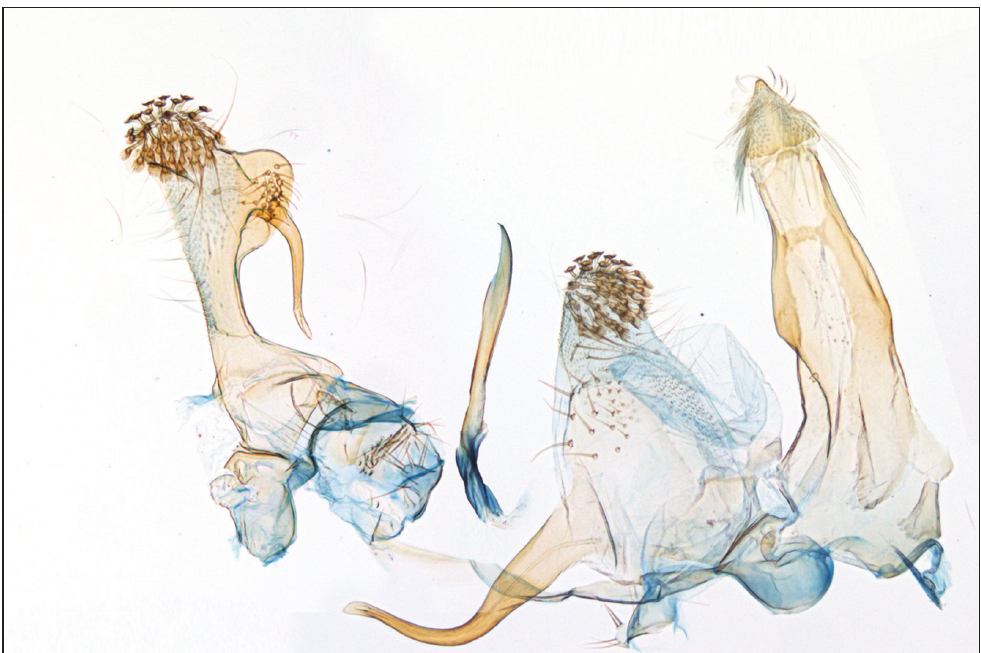
Figure 6. Anarsia innoxiella sp. n., male genitalia, Slovakia (OK5242).